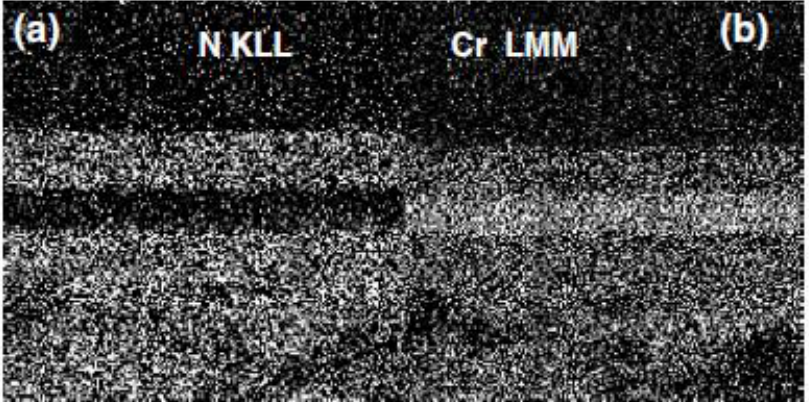
Figure 12. N ( a ) and Cr ( b ) chemical maps of the cross section of multilayer coating [23].